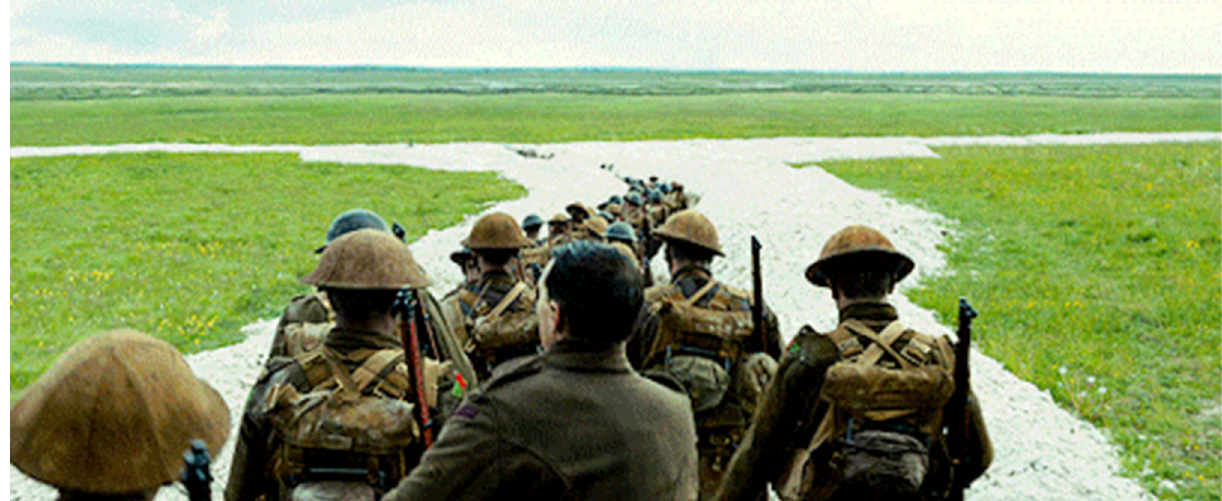
Figure 8. 1917 adapts the visual procedures of the third-person action-adventure game; for example, when characters are entering a space of uncertainty. (Screenshot created by author).